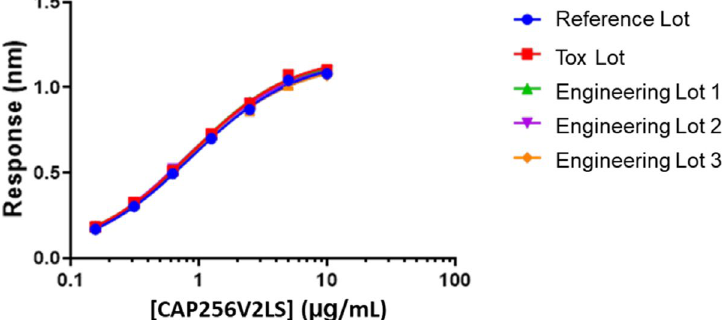
Figure 5. Lot-to-lot consistency of CAP256V2LS sulfation profile. Five independently produced lots of CAP256V2LS at the 50-l scale included one reference lot, one toxicology lot and three consistency-run lots. ( a ) % Relative potency values are shown for binding to HIV-1 antigen accordingly to procedures detailed in materials and methods. Reported value %RP for all lots is compared to reference lot. ( b ) Octet antigen-binding